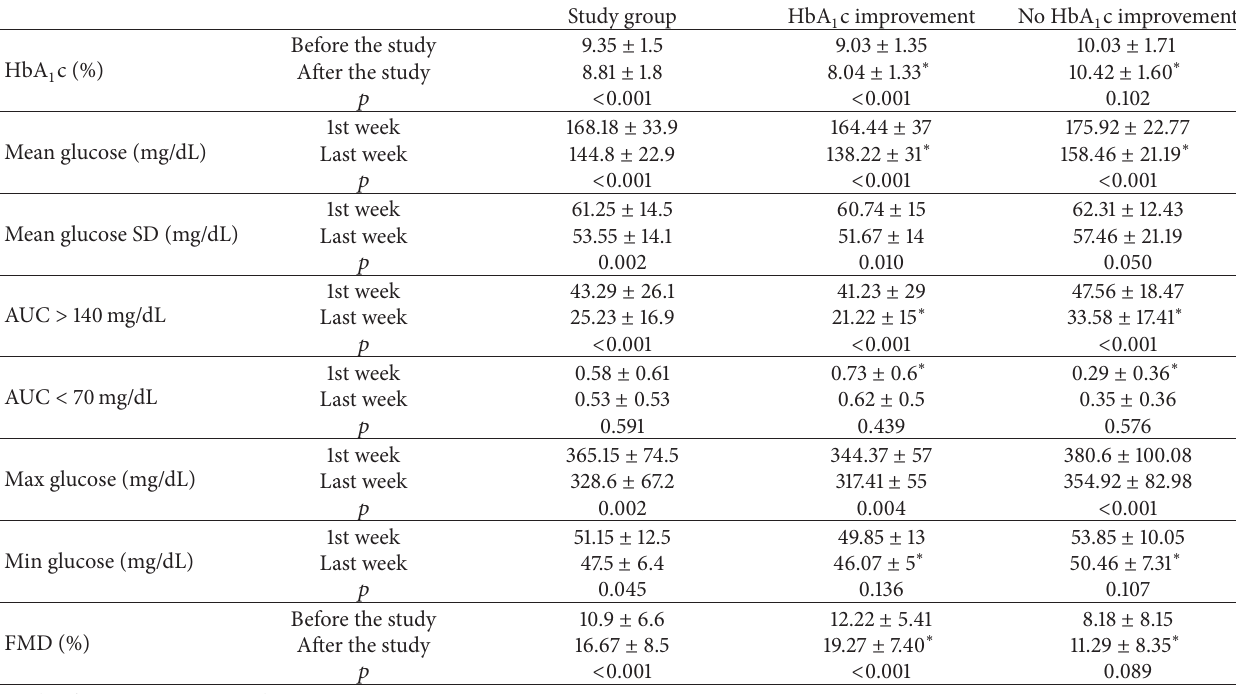
Table 2: Glucose variability during the study in the whole group and depending on HbA 1 c improvement.